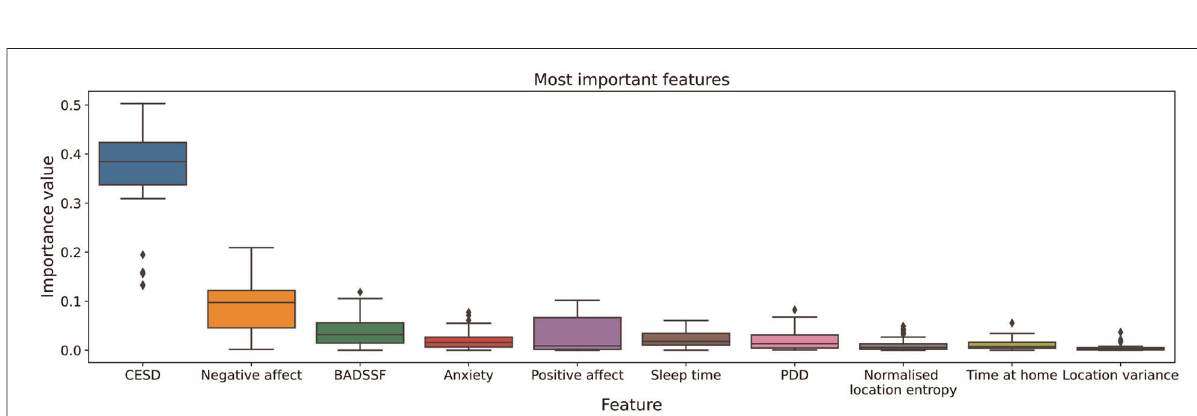
FIGURE 3 The 10 most important of all available features for PHQ-2 prediction. Determined by a Random Forest Regressor with a number of 50 different decision trees. In particular, the EMA data have a great in fl uence on the prediction result: Center for Epidemiological Studies ’ Depression Scale (CESD), negative affect, Behavioral Activation for Depression Scale-Short Form (BADSSF), Personality Dynamics Diary